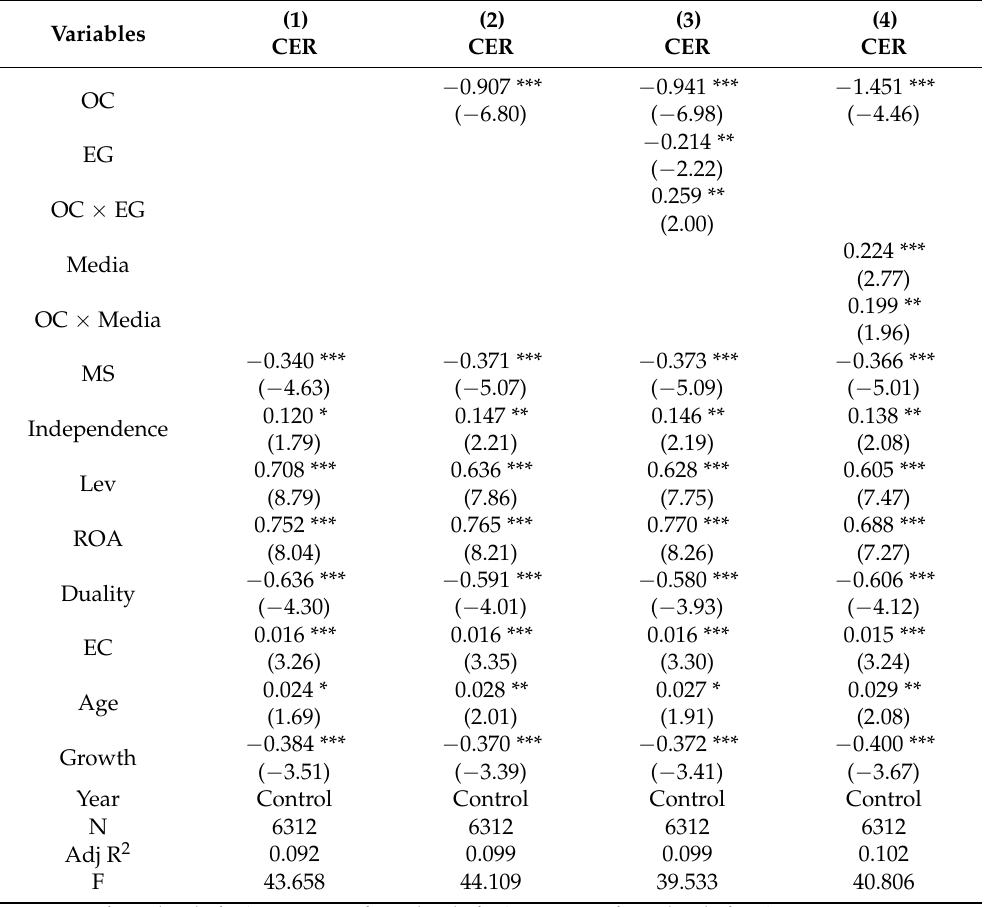
Table A1. Robustness (1)—Random sample test.